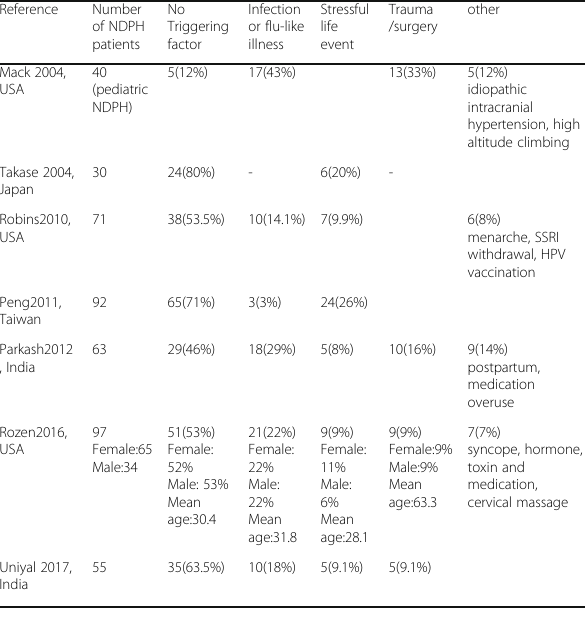
Table 4 (abstract P116). Patients reported NDPH triggers in various published studies Reference Number of NDPH patients